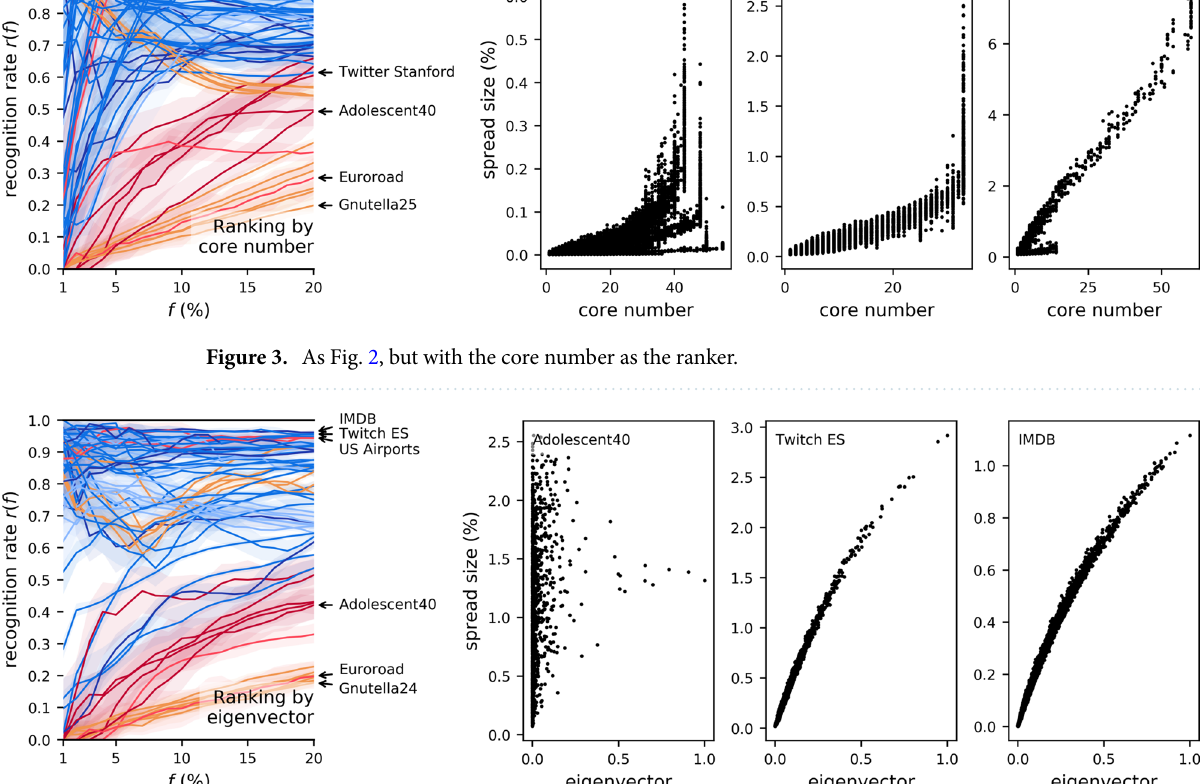
Figure 4. As Fig. 2, but with the eigenvector centrality as the